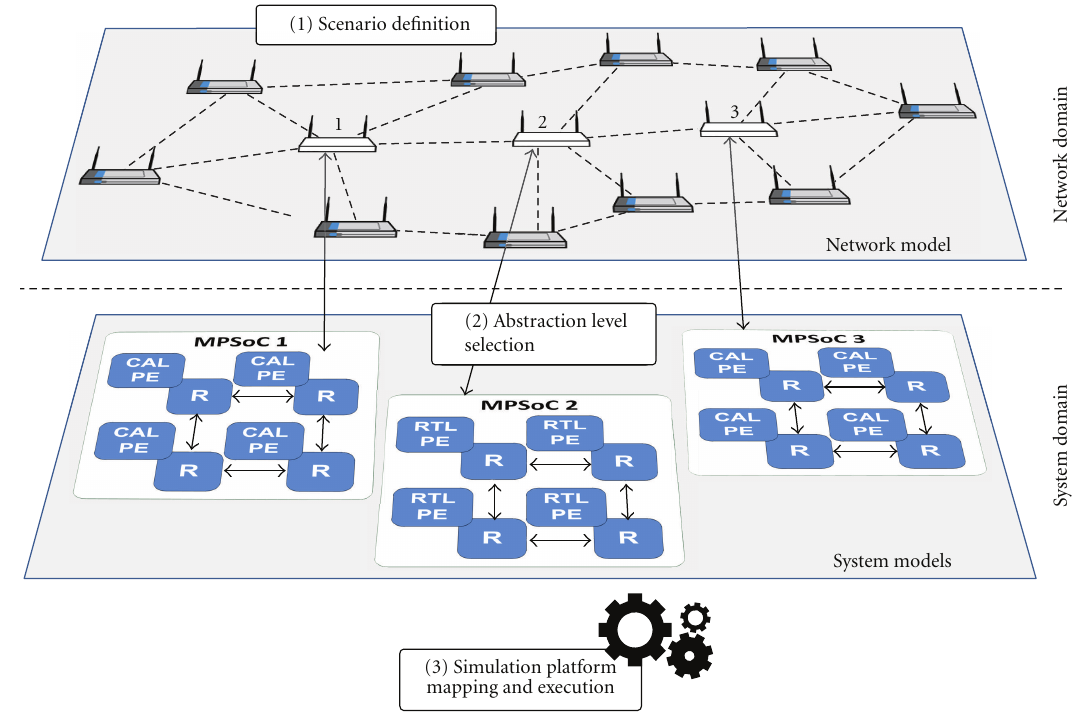
Figure 1: Simulation